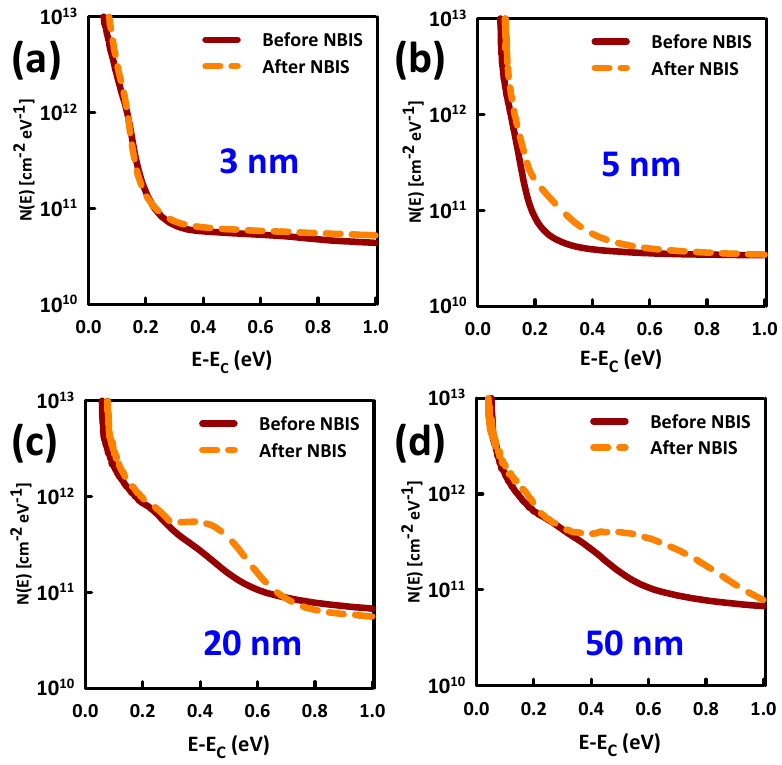
Figure 9. Concentration of donors before and after 10,000 s of negative-gate bias stress combined with visible light illumination (NBIS), ( a ) 3 nm; ( b ) 5 nm; ( c ) 20 nm; ( d ) 50nm.